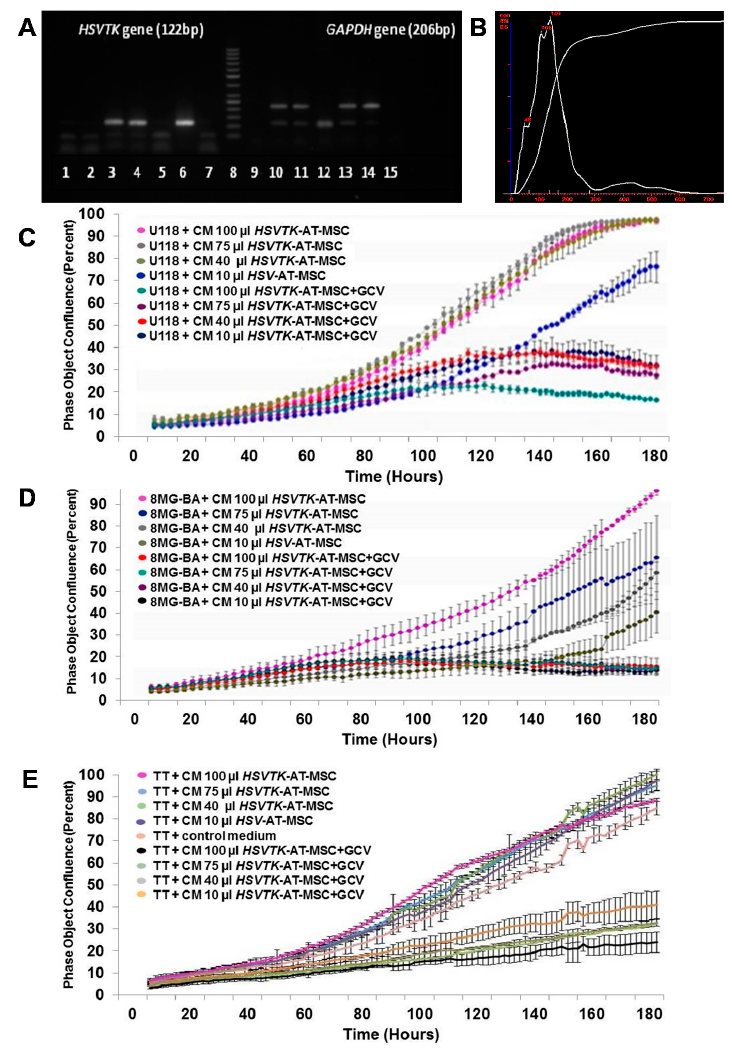
1. Figure 2. Expression of the HSVTK gene in homogenous cultured HSVTK -MSCs and assessment of growth inhibition activity of various tumor cells by CM from MSCs engineered to express the HSVTK gene. ( A ) Detection of HSVTK sequence presence in DNA of MSC cells after polymerase chain reaction (PCR) was visualized by 2% agarose gel electrophoresis: HSVTK PCR gel (1–7): (1 and 7) reaction mixture with no DNA (NTC); (2) PC3 cell (negative control); (3) HSVTK -AT-MSCs; (4) GP-AM / TK; (5) AT-MSCs; (6) plasmid pAPtk (positive control); (8) 50 bp ladder; GAPDH PCR gel (9–15): (9 and 15) reaction mixture with no DNA (NTC); (10) PC3 cell (positive control); (11) HSVTK -AT-MSCs; (12) GP-AM / TK (negative control); (13) AT-MSCs; (14) human genomic DNA (positive control). ( B ) Detection of exosomes released from HSVTK gene transduced MSCs by Nanosight. ( C ) Growth curve of human glioma tumor cell line U118 treated with CM of HSVTK -AT-MSCs in the presence and absence of GCV. Killing activity of CM from HSVTK -AT-MSCs was dose-dependent. ( D ) Dose dependence of HSVTK -AT-MSC conditional medium growth inhibition activity tested on human glioma tumor cell line 8MG-BA. Glioblastoma cell line 8MG-BA was found to be more sensitive to the HSVTK killing e ff ect (Figure 2D). ( E ) CM of HSVTK -AT-MSCs was killing human slowly growing medullary carcinoma cells TT resistant to radiotherapy in a dose-dependent manner in GCV presence and absence. Starting number of tumor cells of all three tumor cell lines in the well of 96-well plate was 3 × 10 4 at the beginning of the